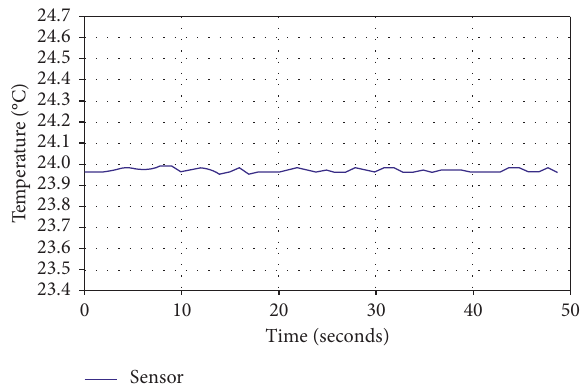
Figure 10: Termal stability of the phantom.